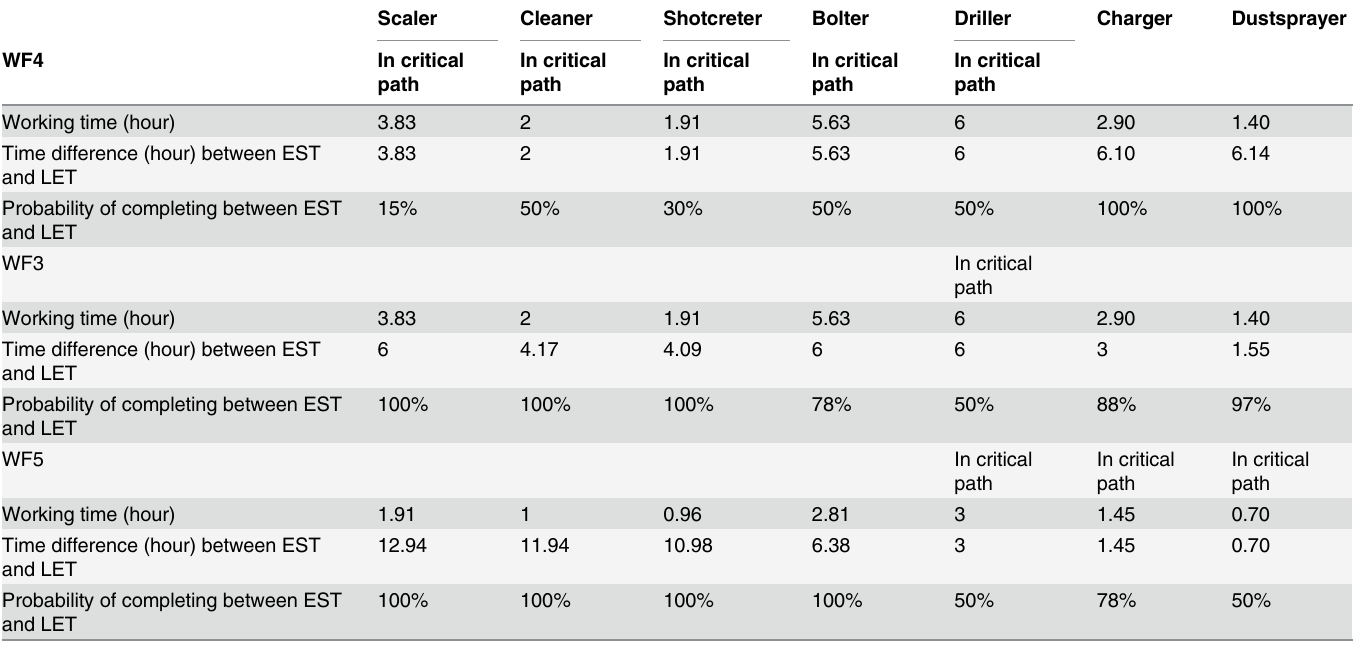
Table 1. Probability and critical path using the conventional method.